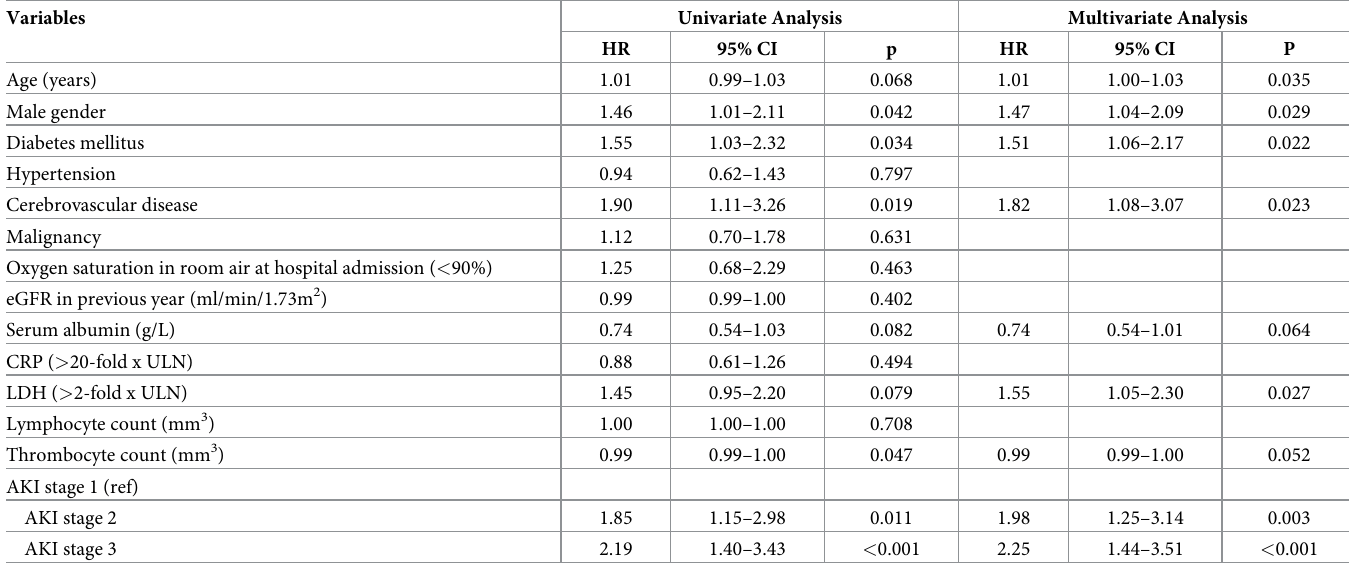
Table 4. Covariates associated with death by Cox survival analysis.